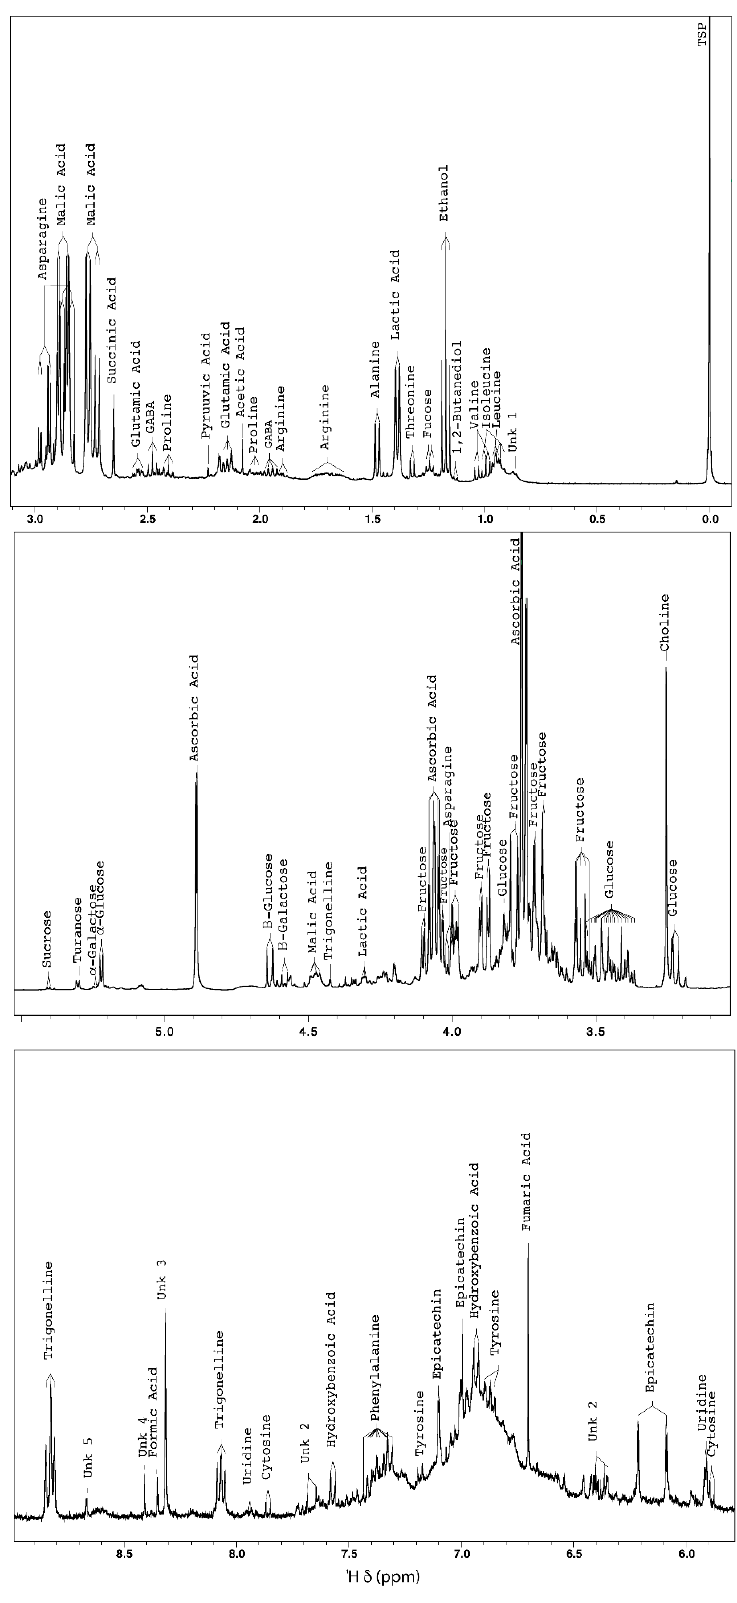
Figure 2. Representative 1 H ‐ NMR spectrum of acerola juice concentrate at δ 0.0–9.0 ppm showing characteristic signals for primary and specialized metabolites or compounds (400 MHz, 300 K, D 2 O, pH 3.35, 20 mM TSP).